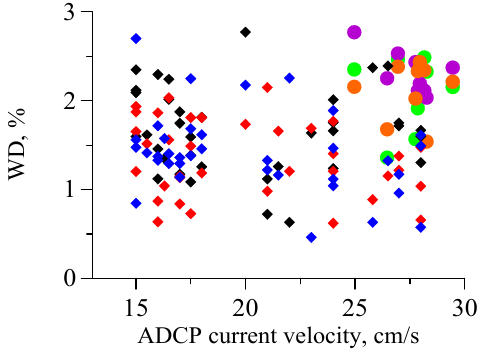
Figure 9. WD in the case study 4.2. vs. ADCP current velocity (minus current velocity at a depth of 1 m). Black/green symbols—S-band, red/violet—C-band, blue/orange—X-band, diamonds—case study 4.2, circles—[29].